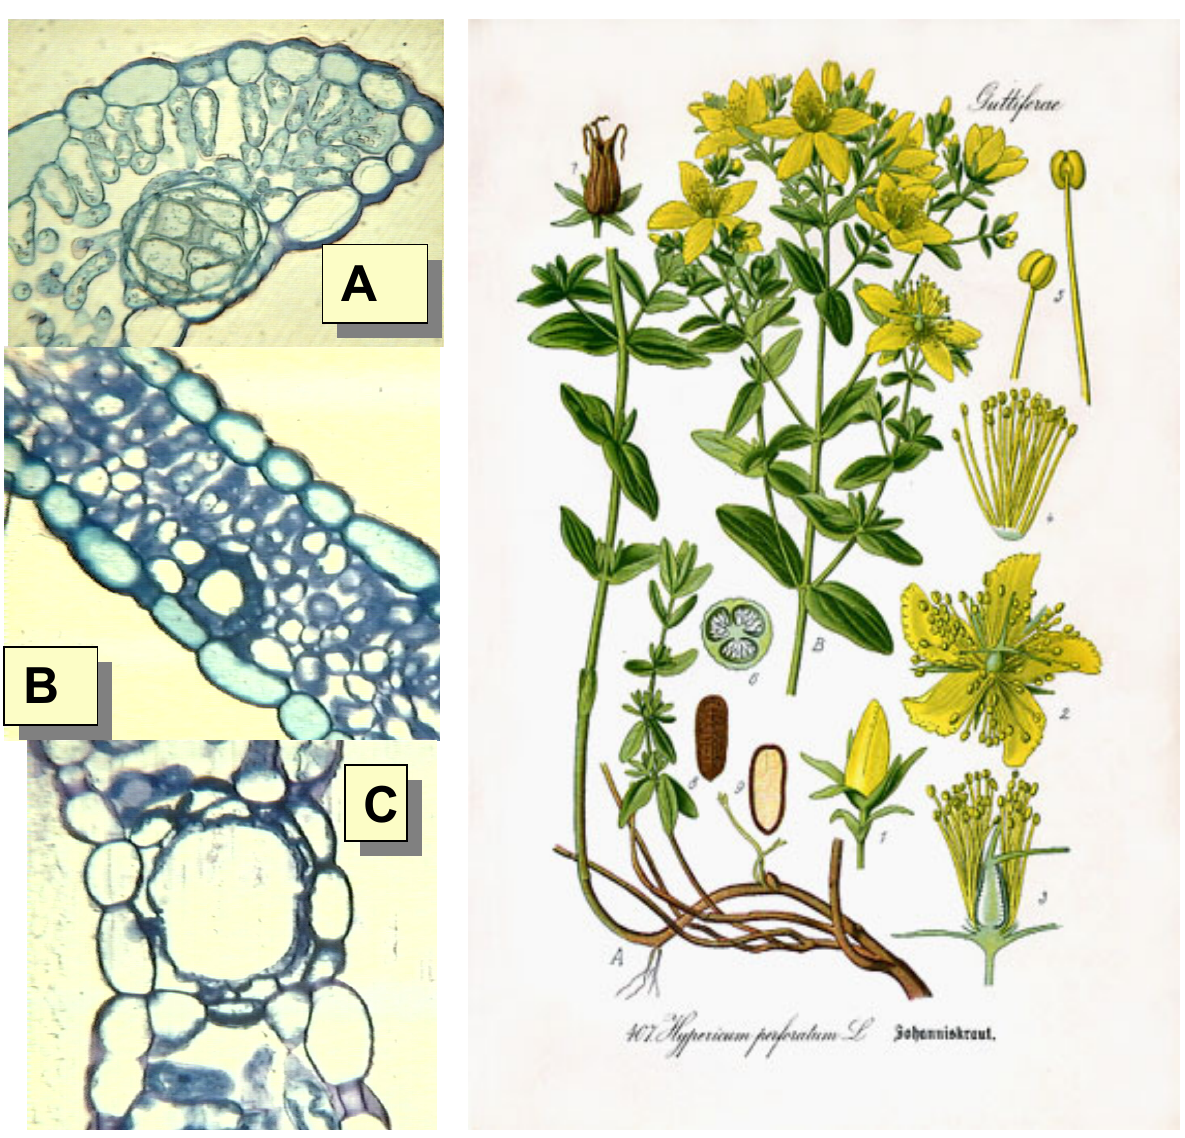
Figure 2. H. perforatum from Prof. Dr. Thomé, Otto Wilhelm, Flora von Deutschland, Österreich und der Schweiz; A) Black nodule from H. perforatum leaves, B) Leaf canal; Translucent cavity (Courtesy Prof. A. Bianchi, University of Parma,